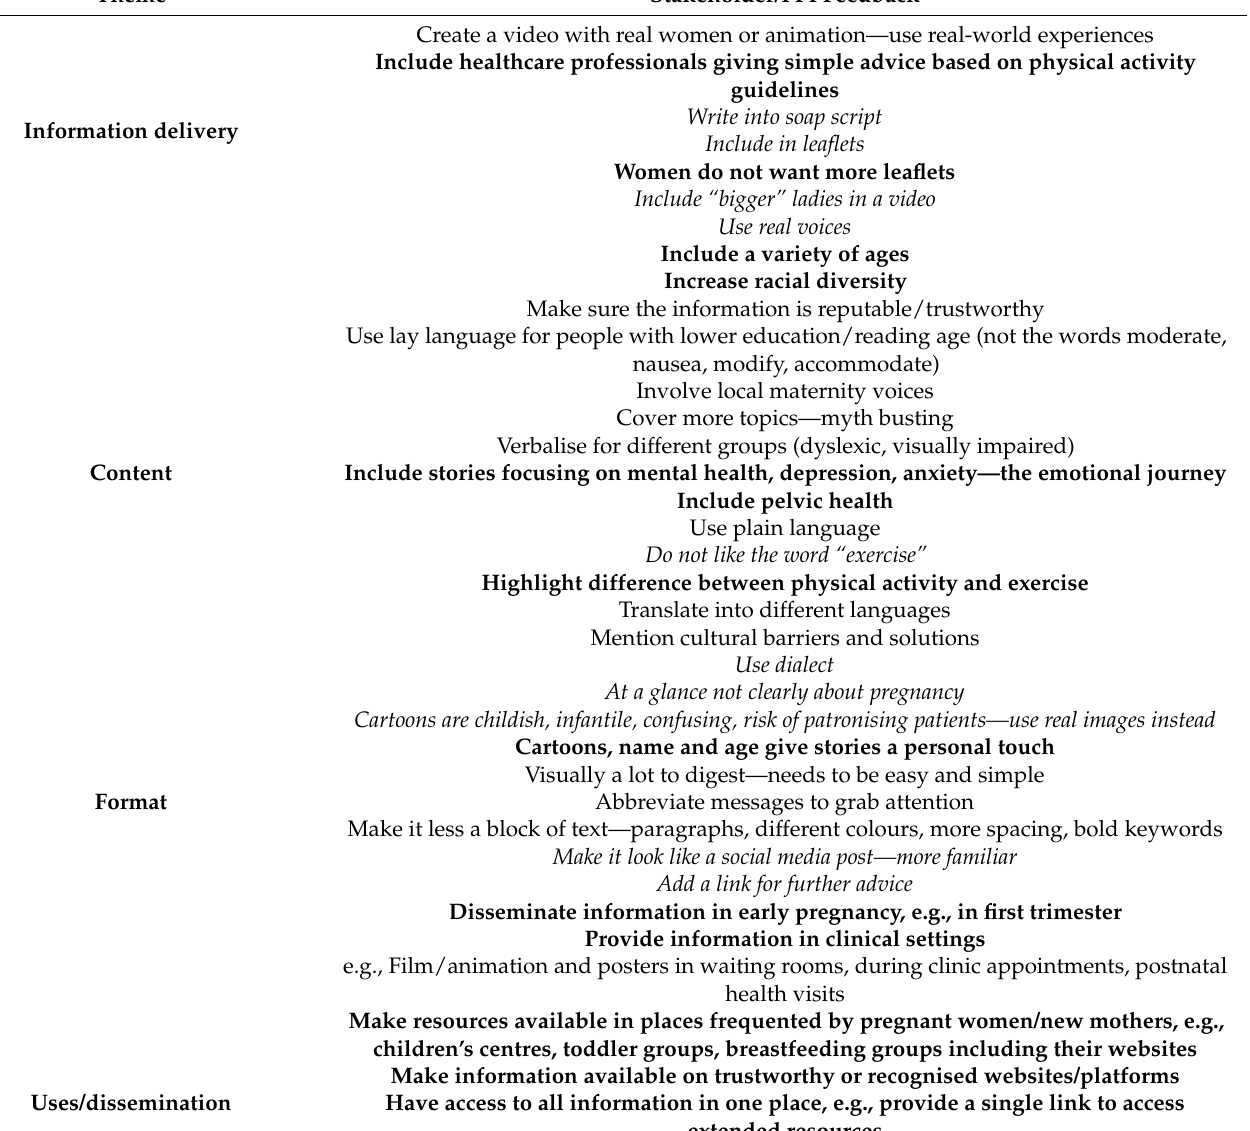
Table 3. Recommendations for further resource